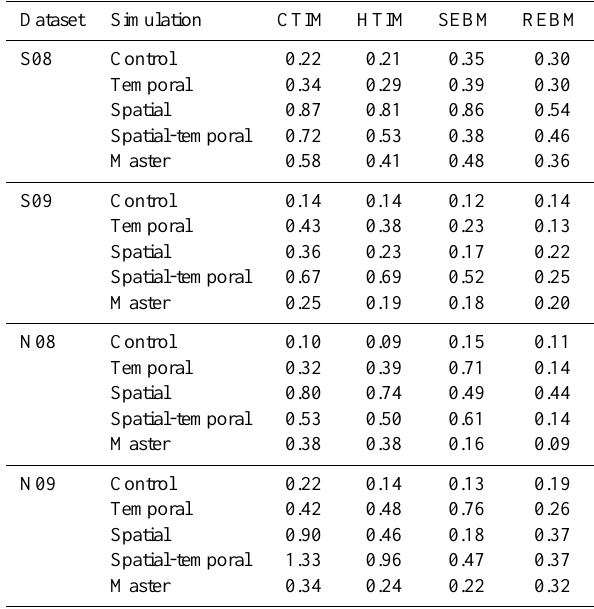
Table 6. RMSE for parameter transferability experiments using real data, expressed in mw.e., for South Glacier (S), North Glacier (N), 2008 (08) and 2009 (09). Except for the master control run, the REBM results are reproduced from MacDougall and Flowers (2011).